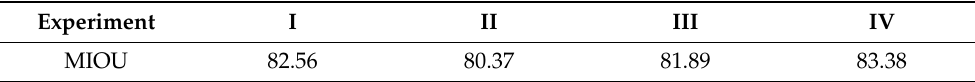
Table 5. Feature fusion MIOU comparison of different semantic segmentation networks on City- scapes dataset .